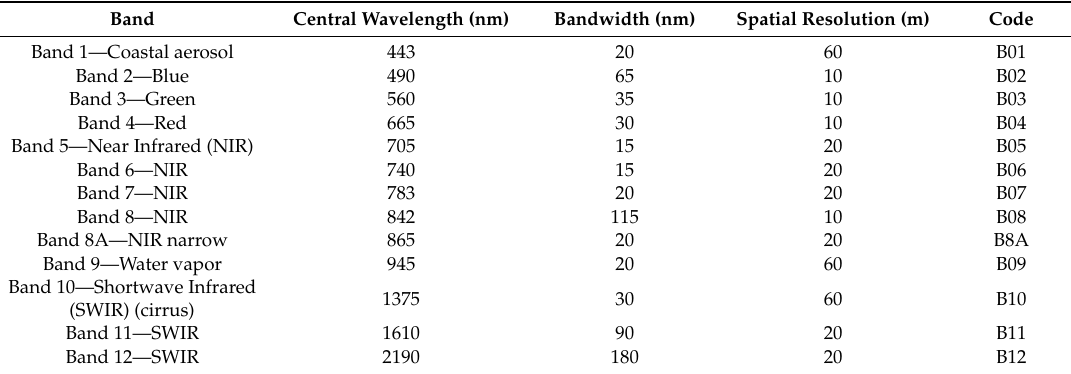
Table 1. Specifications of spectral bands provided by Sentinel